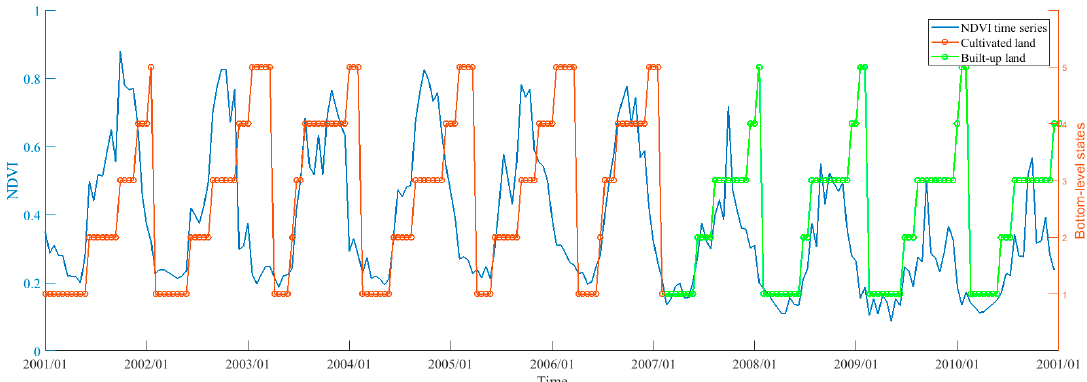
Figure 11. The NDVI time series of a pixel (in blue solid line); the estimated state sequence in the bottom-level HSMM (in circle solid line) whose parent states in the top-level are distinguished by different colors: red represents cultivated land, green represents built-up land.